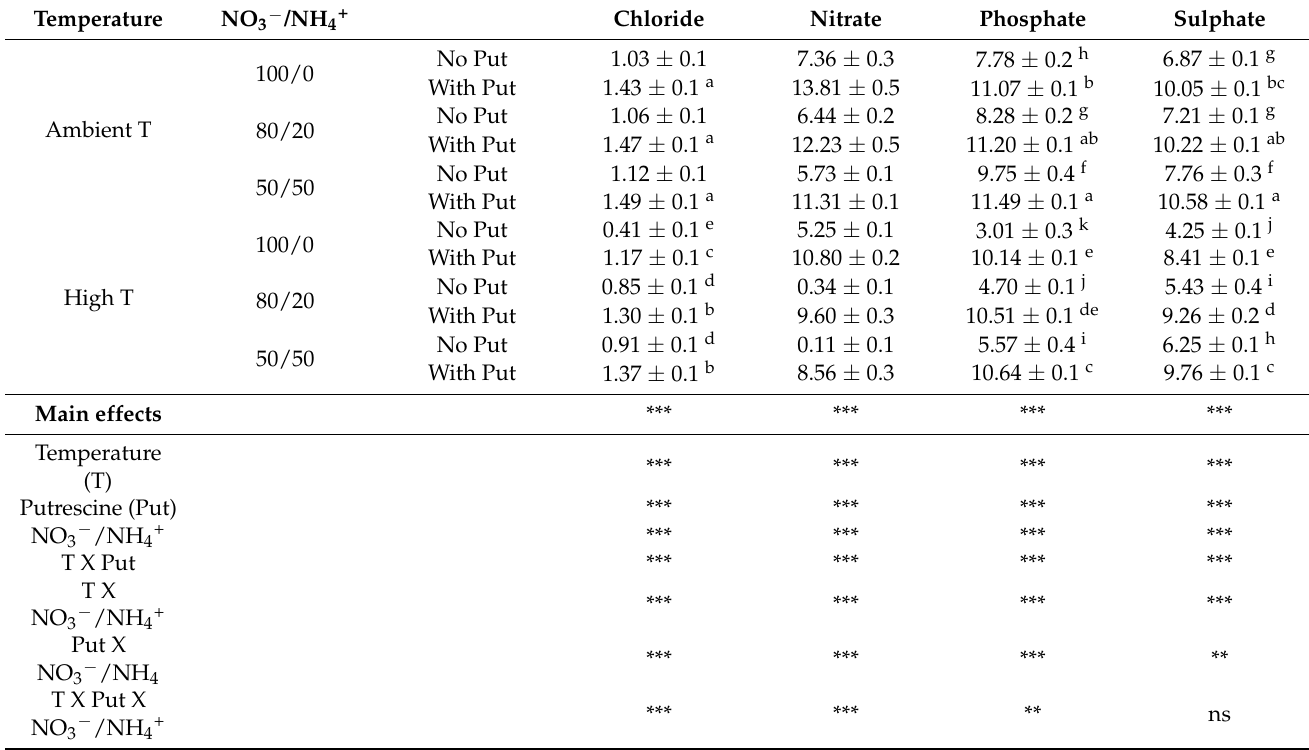
Table 7. Effect of foliar application of putrescine on anions (g kg − 1 FW) in younger leaves of the cauliflower cv. Moonshine at different ration of NO 3 − /NH 4+ and